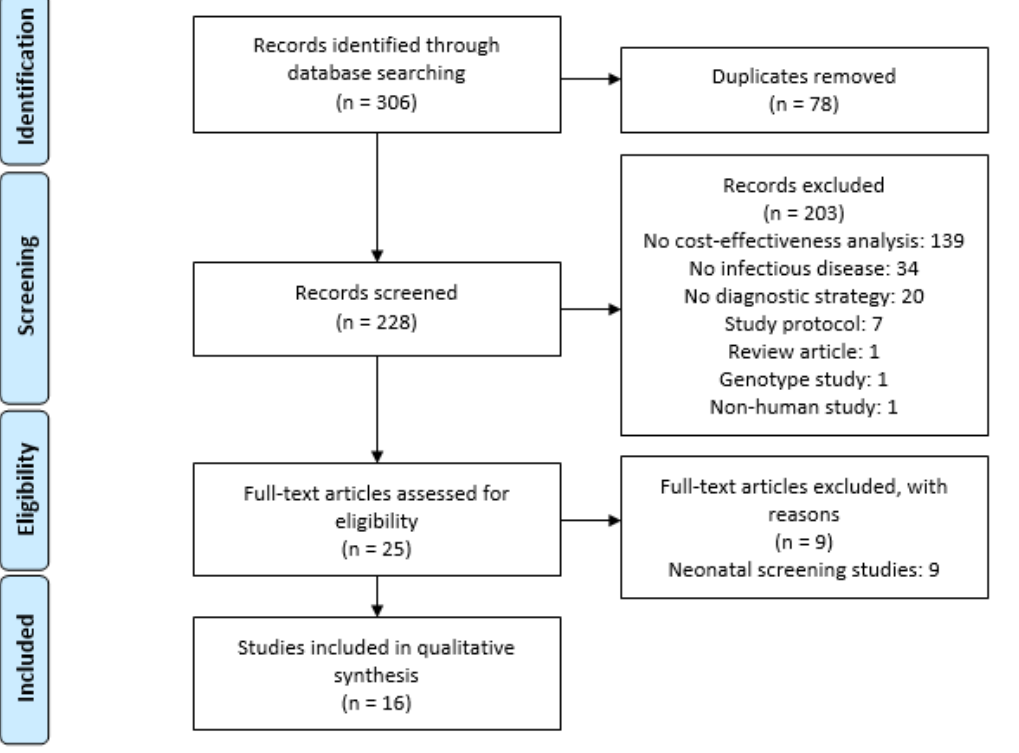
Figure 1. PRISMA flow diagram .